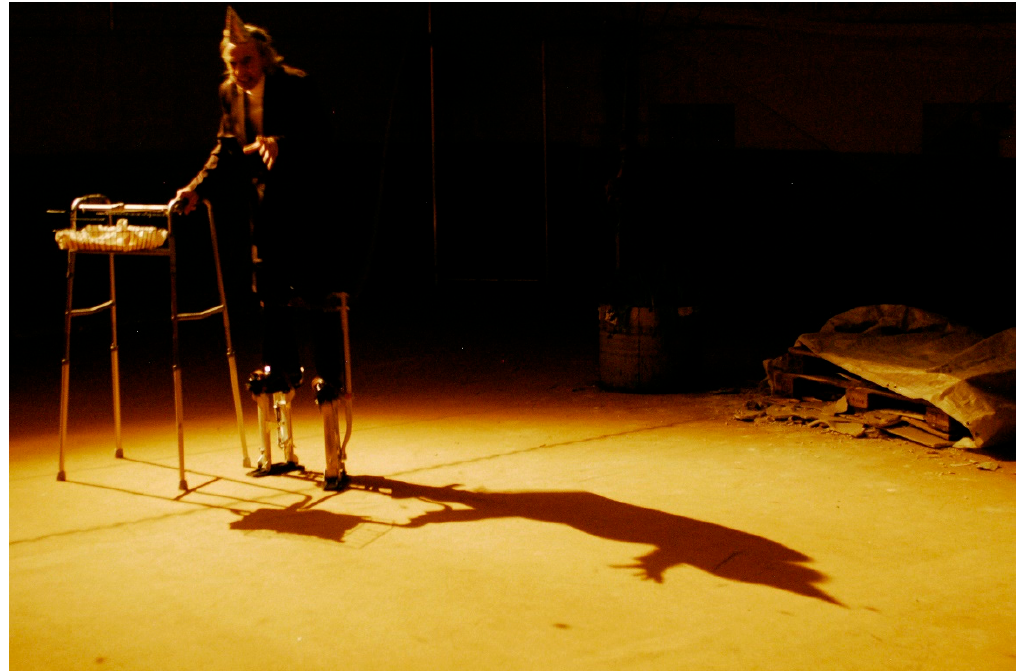
Figure 3. The rabbi, priest and imam played by Adolfo Assor (Photo by Ute Langkafel, 2009).